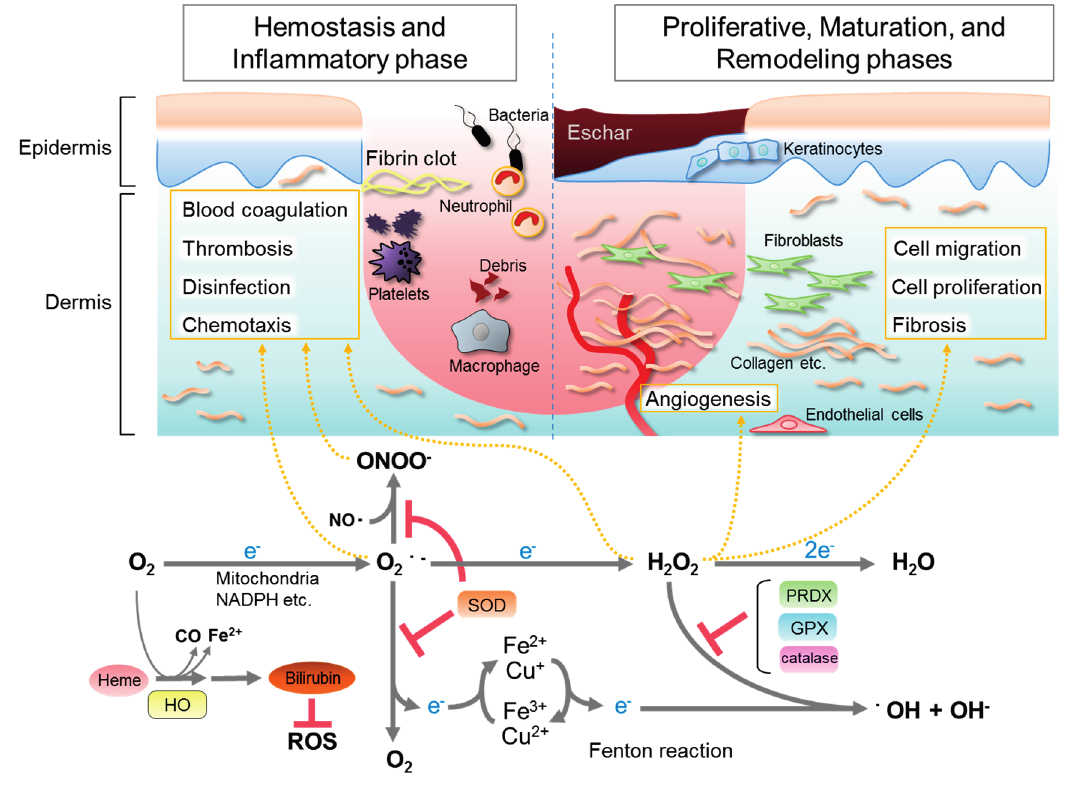
Figure 1. The relation between wound healing and reactive oxygen species (ROS), and generating reactions catalyzed by antioxidative enzymes. In the inflammatory phase, large amounts of superoxide are generated from molecular oxygen mainly by NADPH oxidase expressed in immune cells. A part of the superoxide reacts with nearby nitric oxide, generating peroxynitrite. Superoxide and peroxynitrite attack the invading bacteria and aid in phagocytosis. Superoxide is dismutated to hydrogen peroxide (H 2 O 2 ) and an oxygen molecule by superoxide dismutase (SOD), thus avoiding generating highly deleterious ROS, such as peroxynitrite (ONOO − ) or hydroxyl radicals ( ･ OH). Low levels of H 2 O 2 can serve as a signaling molecule modulating various signaling pathways that regulate blood coagulation, thrombosis, migration, proliferation, fibrosis, angiogenesis, and so on, in hemostasis phase, proliferative phase, and in maturation and remodeling phase. H 2 O 2 is then detoxified by a series of enzymes such as catalase, glutathione peroxidase (GPX), and peroxiredoxin (PRDX) to avoid generating harmful hydroxyl radicals via the Fenton reaction. The physiological roles of NO and CO are omitted in this